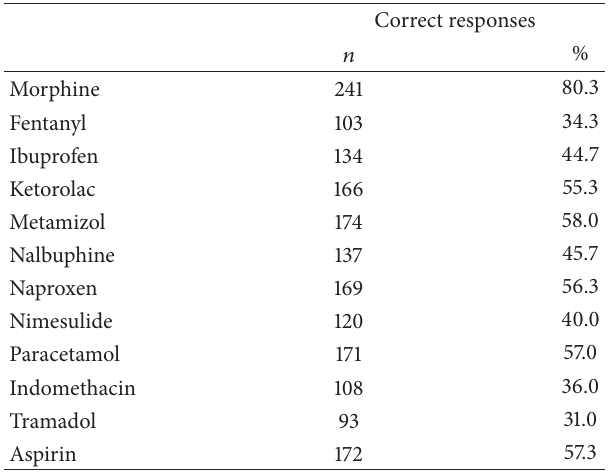
Table 8: Nursing students knowledge about which of the following drugs are or are not opioid or